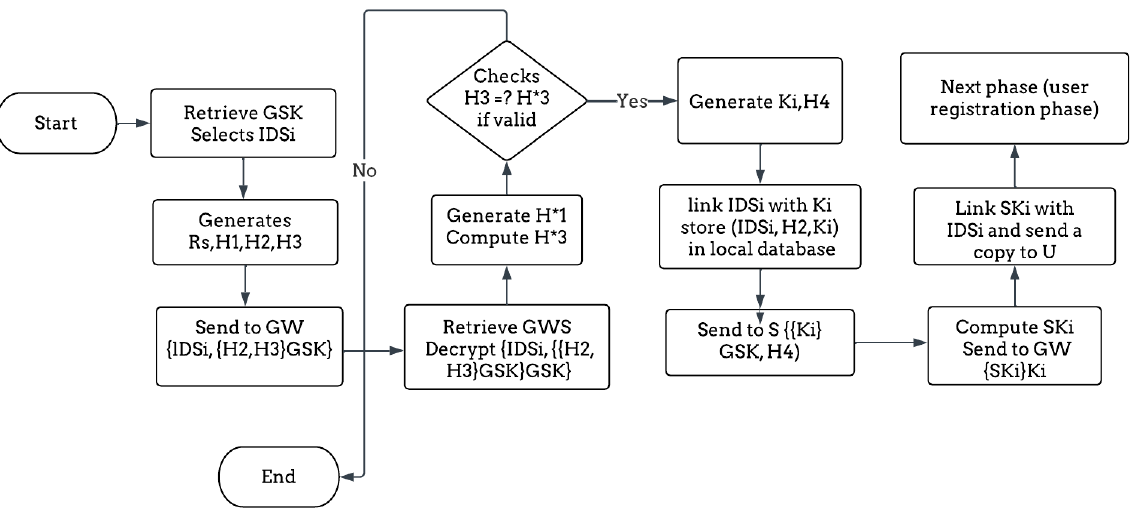
Figure 3. The flow diagram of the sensor registration phase.